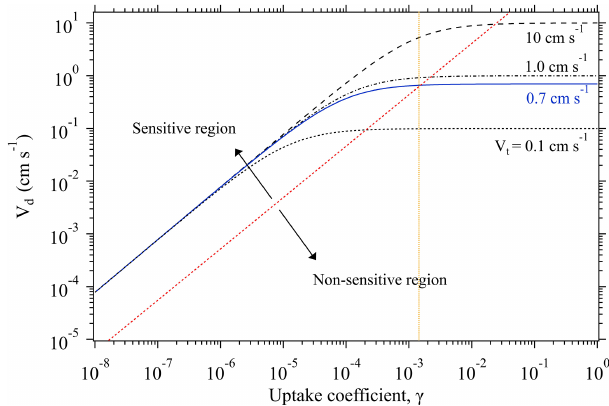
Figure 1. Change of deposition velocity V d of SO 2 as a function of its uptake coefficient γ , at different transport-limited deposition velocity V t conditions. The blue line shows the V t obtained from our chamber measurements of O 3 deposition on KI samples and used for γ derivation of the uptake experiments. The orange dotted line indicates the upper limit of the derivable γ by our chamber system. Based on the sensitivity of the change of V d against the variation of γ , each function curve can be deemed to have two regions: sensitive and non-sensitive regions, as separated by the red dotted line. All the function curves correspond to the case with a constant experimental temperature of